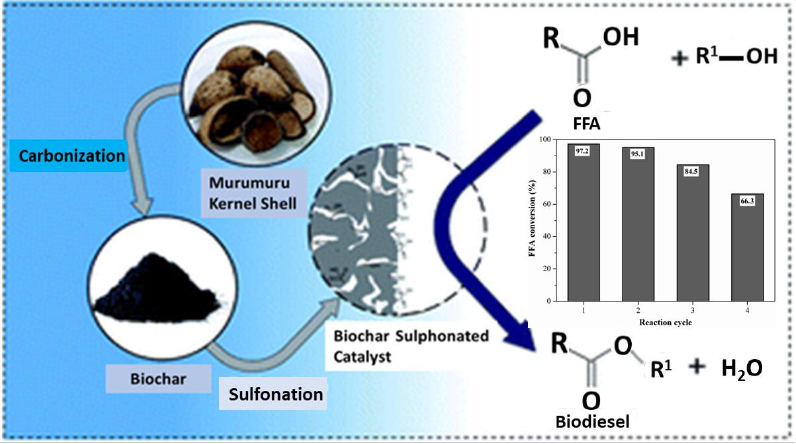
Figure 11. Heterogeneous acid catalysts synthesized from murumuru kernel shells for fatty acid esterification reactions. Adapted with permission from ref. [41].